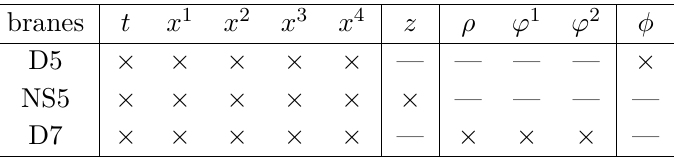
Table 3 . Brane picture underlying the AdS 6 × S 2 × Σ 2 solution T-dual to Brandhuber-Oz. The system is BPS / 4